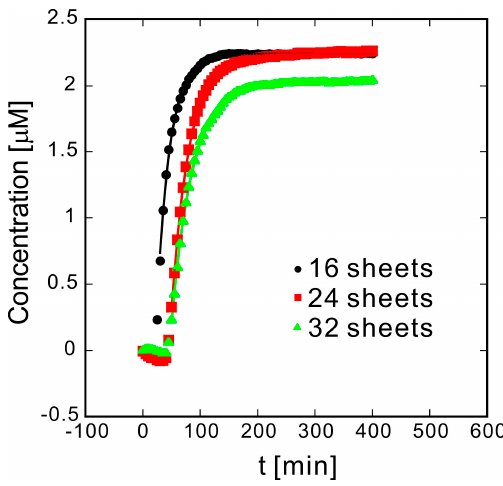
Figure 4. Time dependence of methylene blue absorbance at 664 nm for different quantities of laminated sheets. The markers indicate experimental results, and the solid line is the result of fitting the experimental data to the exponential function ( m 1 × (1 − e ( − m 2 × ( t − m 3)) ) using the least squares method. Table 1. Thickness δ and porosity α of samples with n sheets and related parameters 1 of methylene blue